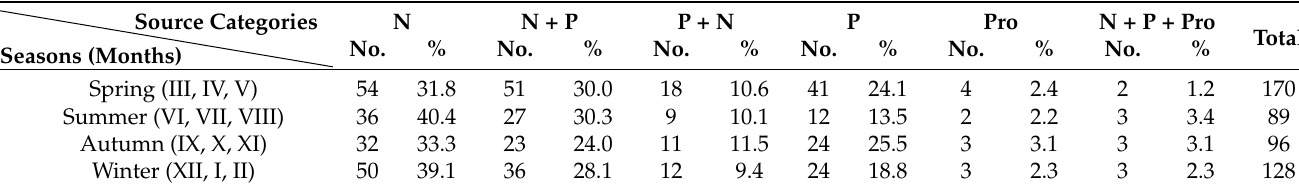
Table 3. Nectar and Pollen flow during different seasons in Al-Baha region, Southwestern Saudi Arabia.